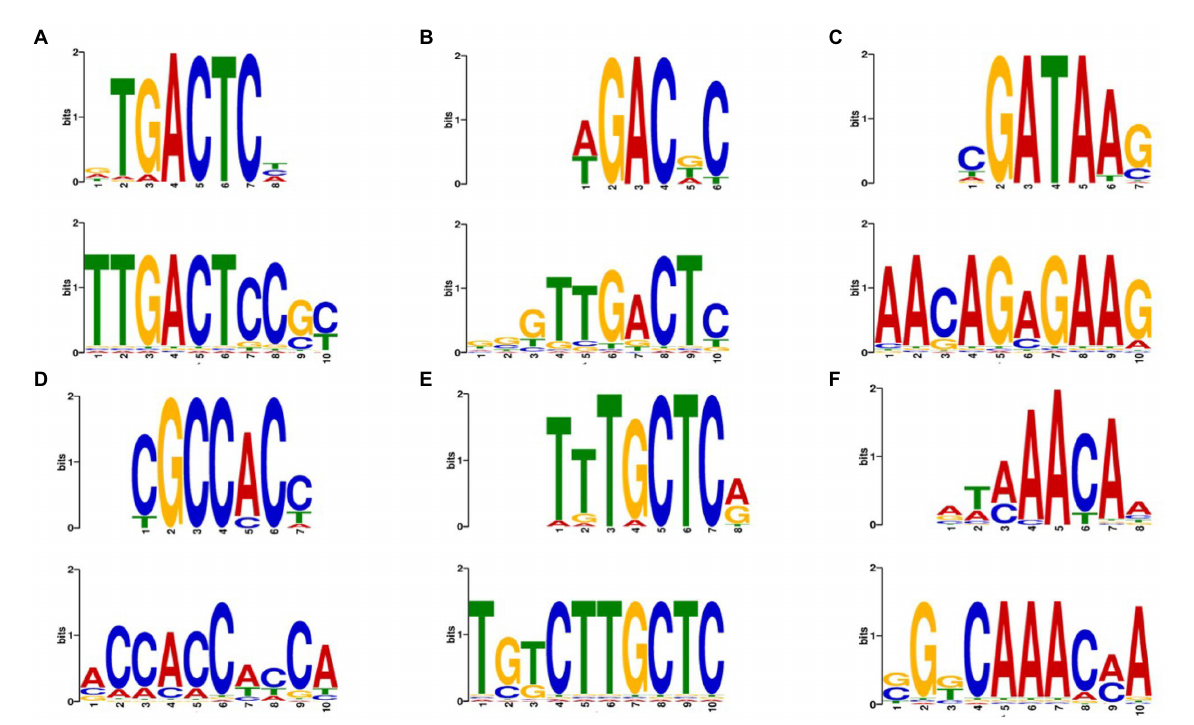
FIGURE 6 Examples of putative motifs aligned with transcription factors motifs from the JASPAR database using TOMTOM. (A) Top motif is the binding motif for ARG81 from Saccharomyces cerevisiae . Bottom motif is from SCJ condition. Eukaryotic orthologous groups (KOG) class: Amino acid transport and metabolism. Value of p : 1.08 e –03. E -value: 1.51 e + 00 (B) Top motif for AGR80 from S. cerevisiae . Bottom motif is from 42 ° C condition. KOG class: Amino acid transport and metabolism. Value of p : 4.98 e –03. E -value: 8.76 e –01. (C) Top motif for DAL80 from S. cerevisiae . Bottom motif is from ethanol 2% condition. KOG class: Amino acid transport and metabolism. value of p : 3.38 e –02. E -value: 5.95 e + 00. (D) Top for RPN4 from S. cerevisiae . Bottom motif is from 42 ° C condition. KOG class: Chromatin structure and dynamics. value of p : 4.15 e –03. E -value: 7.31 e –01. (E) Top motif for MAC1 from S. cerevisiae . Bottom motif is from ethanol 2% condition. KOG class: Secondary metabolites biosynthesis transport and catabolism. Value of p : 4.15 e –03. E -value: 7.30 e –01. (F) Top motif for HCM1 from S. cerevisiae . Bottom motif is from SCJ condition. KOG class: Chromatin structure and dynamics. Value of p : 3.44 e –02. E -value: 6.05 e +